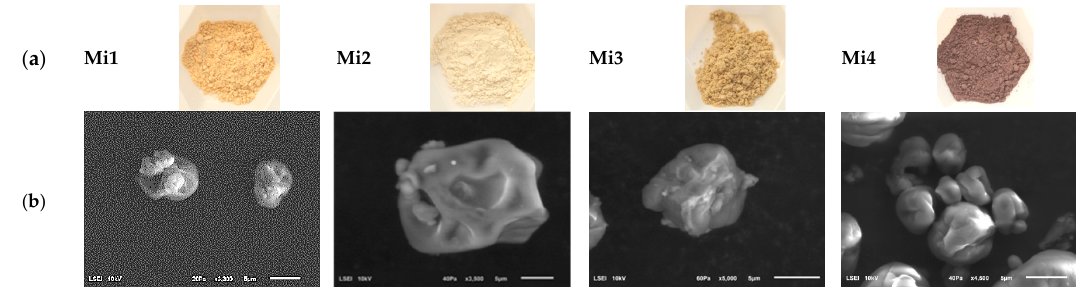
Figure 1. Morphology of microcapsules of iron encapsulated in thermo-resistant modified starch: ( a ) digital images; ( b ) scanning electron microscopic micrographs. FS—ferrous sulphate; FL—ferrous lactate; Mi1—FS; Mi2—FS and Vitamin C; Mi3—FL; Mi4—FL and Vitamin C.